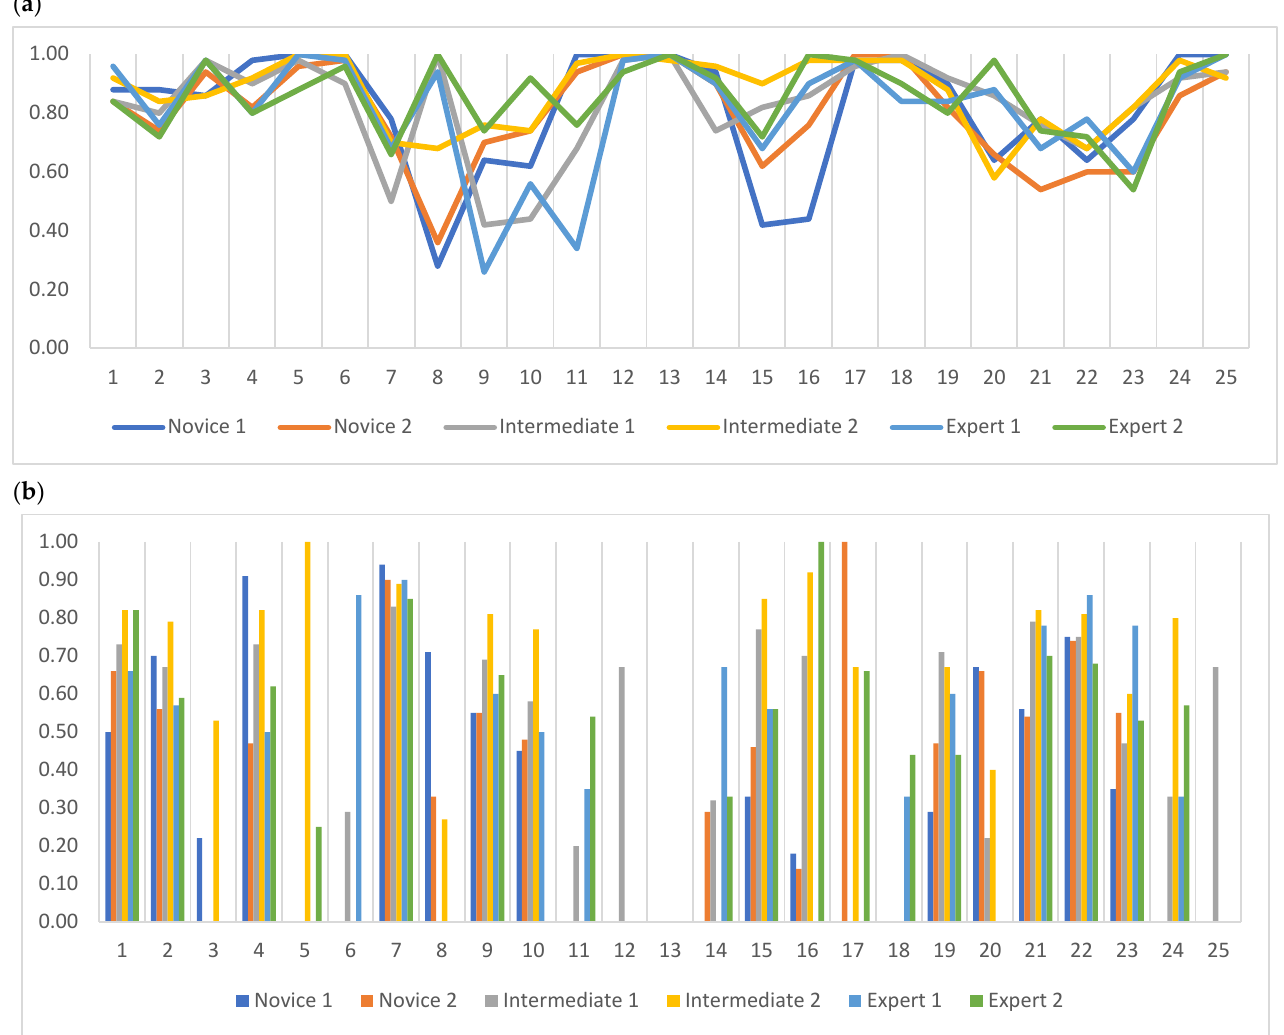
Figure 5. Intra-reader agreement measurements with ( a ) prevalence-adjusted and bias-adjusted Kappa (PABAK) and ( b ) proportion of positive agreement (PPA). 1. Normal, 2. Increased translucency incl. sub-categories, 3. Increased translucency, 4. Pneumothorax, 5. Cysts/bullae, 6. Emphysema, 7. Decreased translucency incl. sub-categories, 8. Decreased translucency, 9. Infiltrate incl. sub-categories, 10. Infiltrate, 11. Infection, 12. Abscess, 13. Tuberculosis, 14. Malignant, 15. Diffuse lung changes incl. sub-categories, 16. Diffuse lung changes, 17. Fibrosis, 18. Chronic pulmonary changes, 19. Stasis/Edema, 20. Costophrenic angle blunting, 21. Pleural effusion, 22. Costophrenic